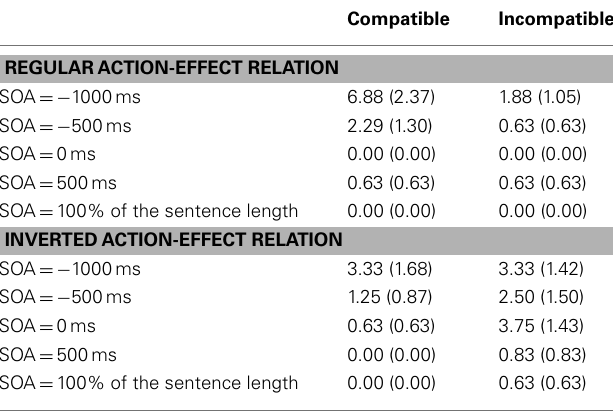
Table 2 | Mean error rates (in %) and standard errors of error rates (in parentheses) in Experiment